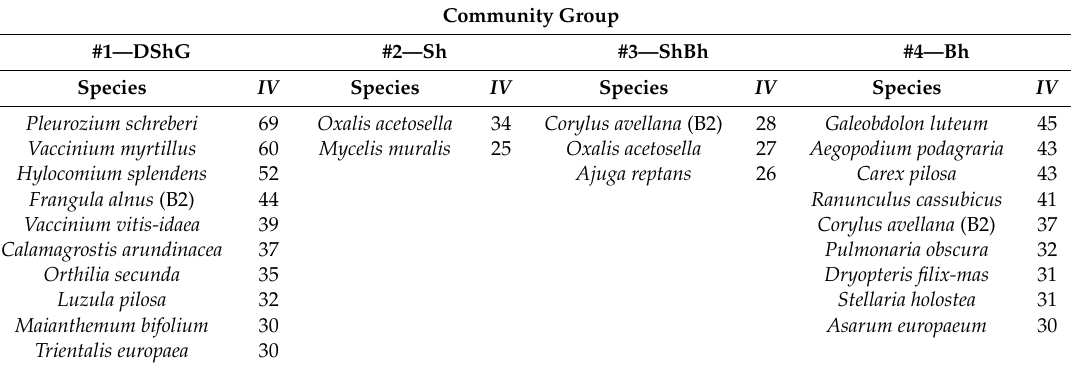
Table 3. Indicator values (IndVal) for species in community groups of spruce and spruce–aspen / birch